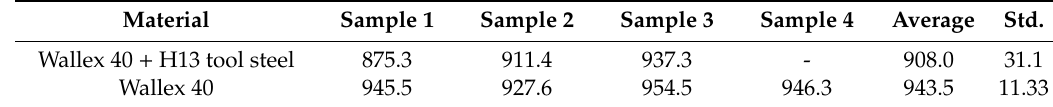
Table 5. Ultimate Tensile Strength (UTS) of the repaired samples.